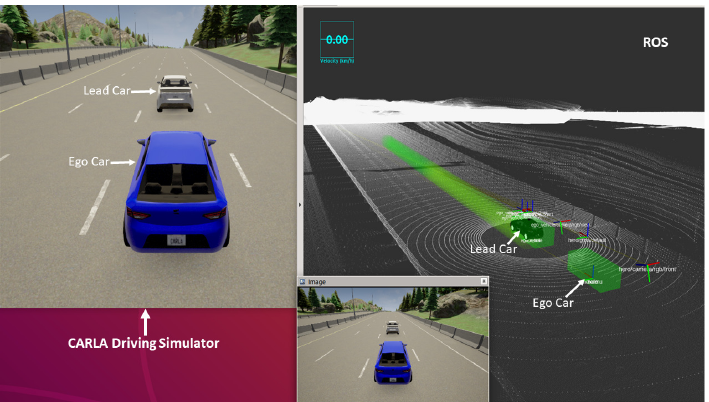
Figure 10. Setup used for the car-following simulation: A bridge between CARLA driving simulator and